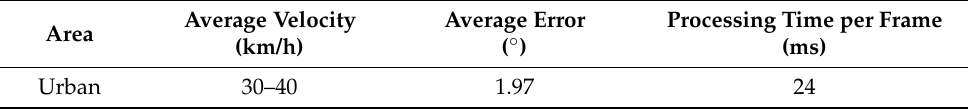
Table 3. Average attitude error and the processing time per frame of the urban road